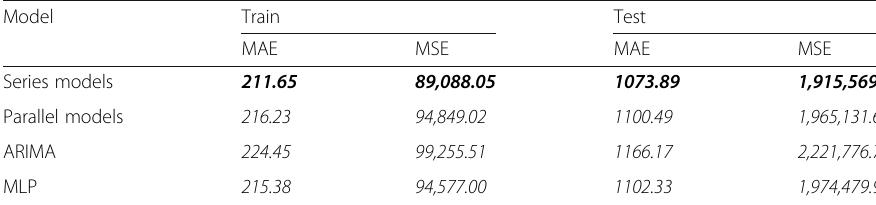
Table 4 Overall performance of series and parallel models for SZII Model